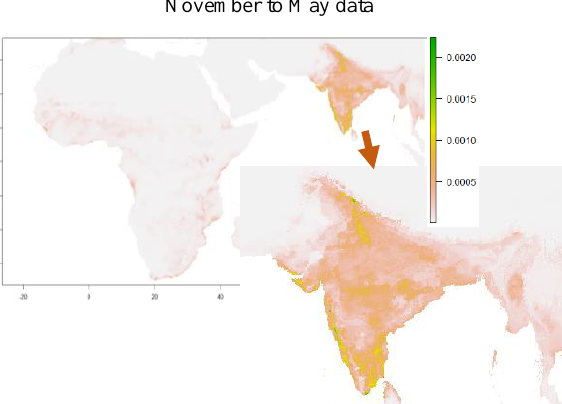
Table 2. Environmental variables used for modeling of